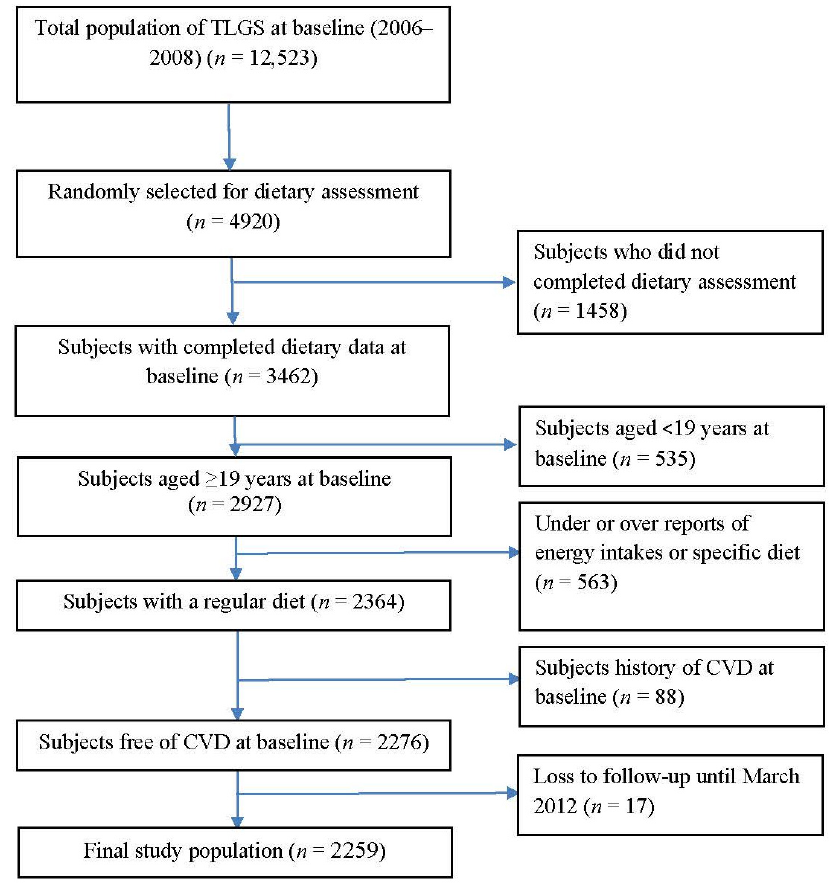
Figure 1. The flowchart of the study population.